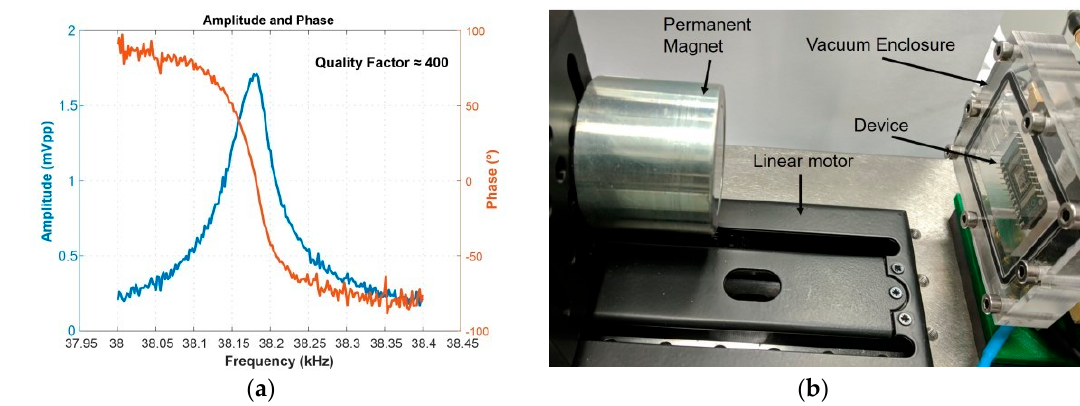
Figure 3. ( a ) Amplitude and phase measurements of one DETF. ( b ) Picture of the measurement setup and its components.